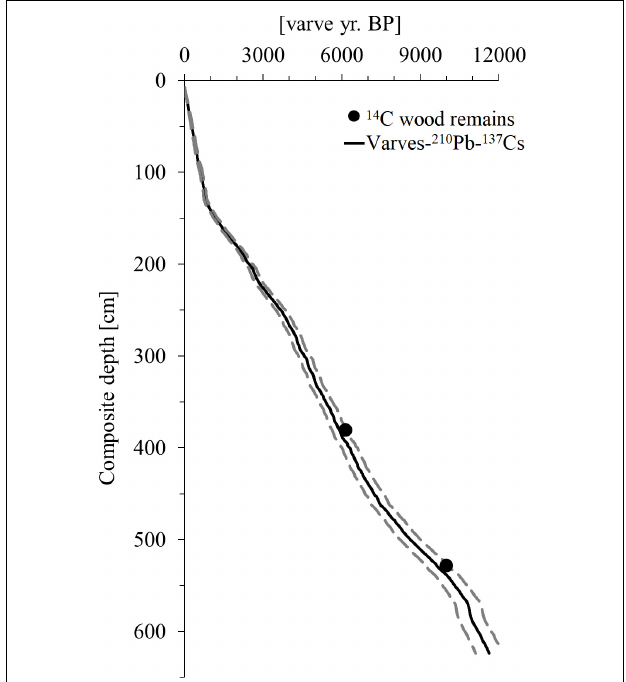
FIGURE 2 | Age model of the Lake Chatyr Kol sediment record (Kalanke et al., Under review). The age model (black line) is based on varve counting combined with 210 Pb and 137 Cs measurements. Dashed lines indicate the varve counting error (Kalanke et al., Under review). Black dots with 2 σ error ranges represent AMS 14 C dates of terrestrial plant macro